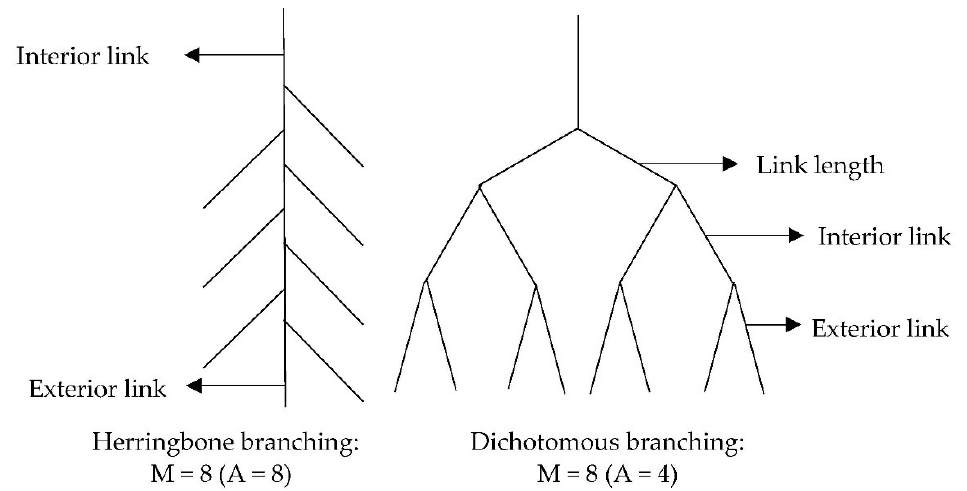
Figure 1. Schematic representation of Fitter’s link-based parameters used to describe root topology. A link is defined as a piece of the root between two branching points (interior link) or between a branch and a meristem (exterior link). The magnitude (M) of the overall root system represents the number of exterior links, which equals the number of meristems in a root. The magnitude of an individual link within the root system represents the total number of root segments connected to the shoot through that specific link. The altitude of the overall root system (A) is the number of links in the longest path from an exterior link to the most basal link of the root system.